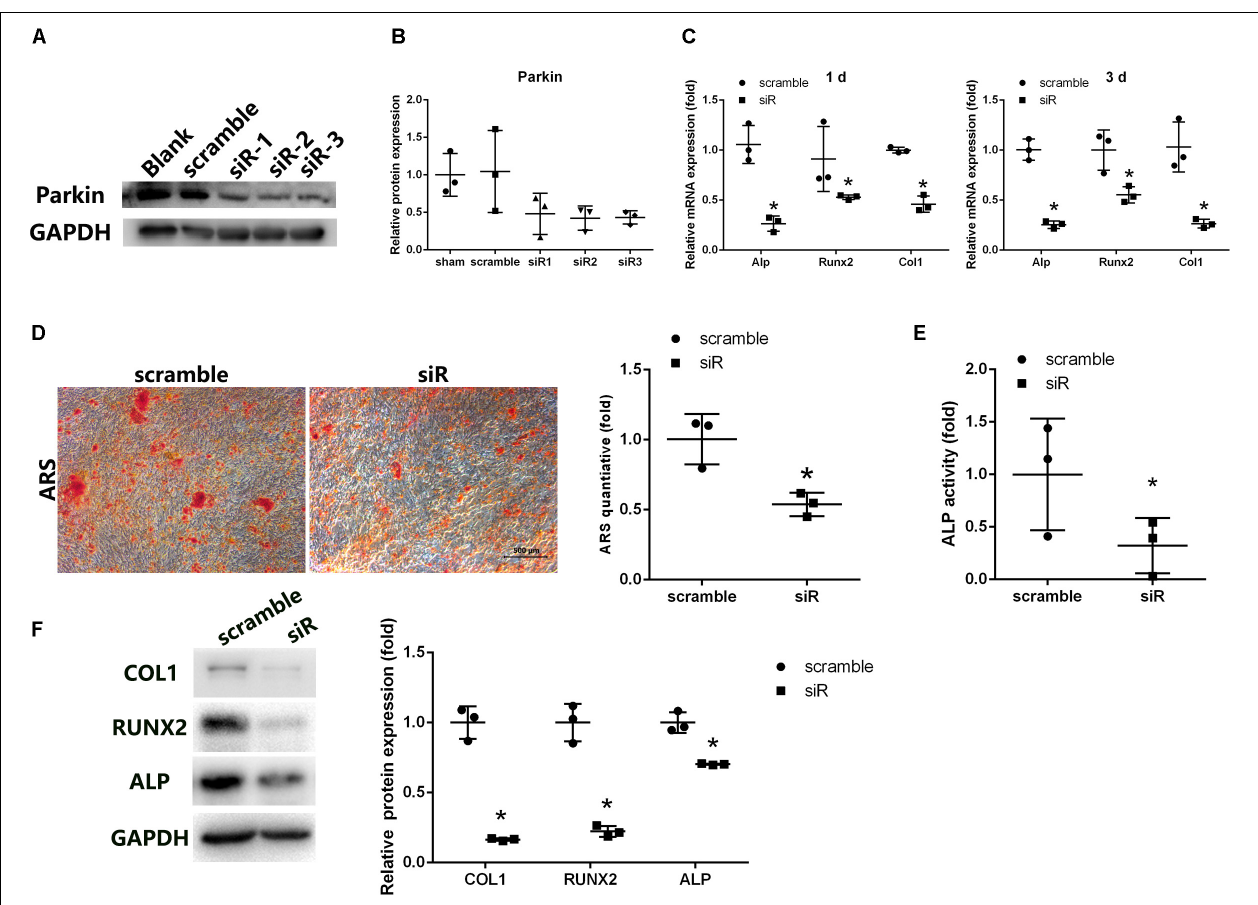
FIGURE 2 | Parkin knockdown suppresses osteogenic differentiation of BMSCs. (A,B) Protein levels of Parkin were analyzed by WB analysis at day 3 after small-interfering RNA treatment. (C) Osteo-specific genes Alp, Runx2, and Col1 were analyzed by RT-qPCR at days 1 and 3 after osteogenic induction. (D) Mineral deposits were determined by Alizarin Red staining at day 12 after osteogenic induction. (E) Alkaline phosphatase activity was determined at day 3 of osteogenic differentiation of BMSCs. (F) Expression levels of COL1, RUNX2, and ALP were determined by WB analysis at day 3 of osteogenic differentiation. Protein expression levels were normalized to glyceraldehyde-3-phosphate dehydrogenase (GAPDH). Data are expressed as the mean ± SD of three independent experiments, and one of three independent experiments is shown. * P < 0.05 vs. BMSCs treated with negative control